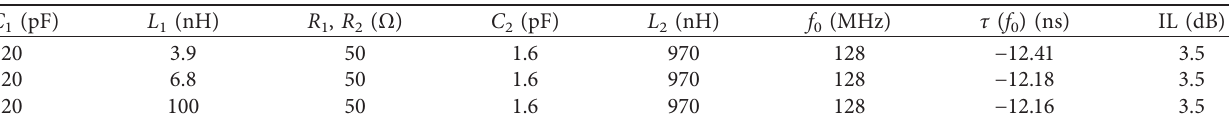
1 values when band-pass negative group delay occurs.